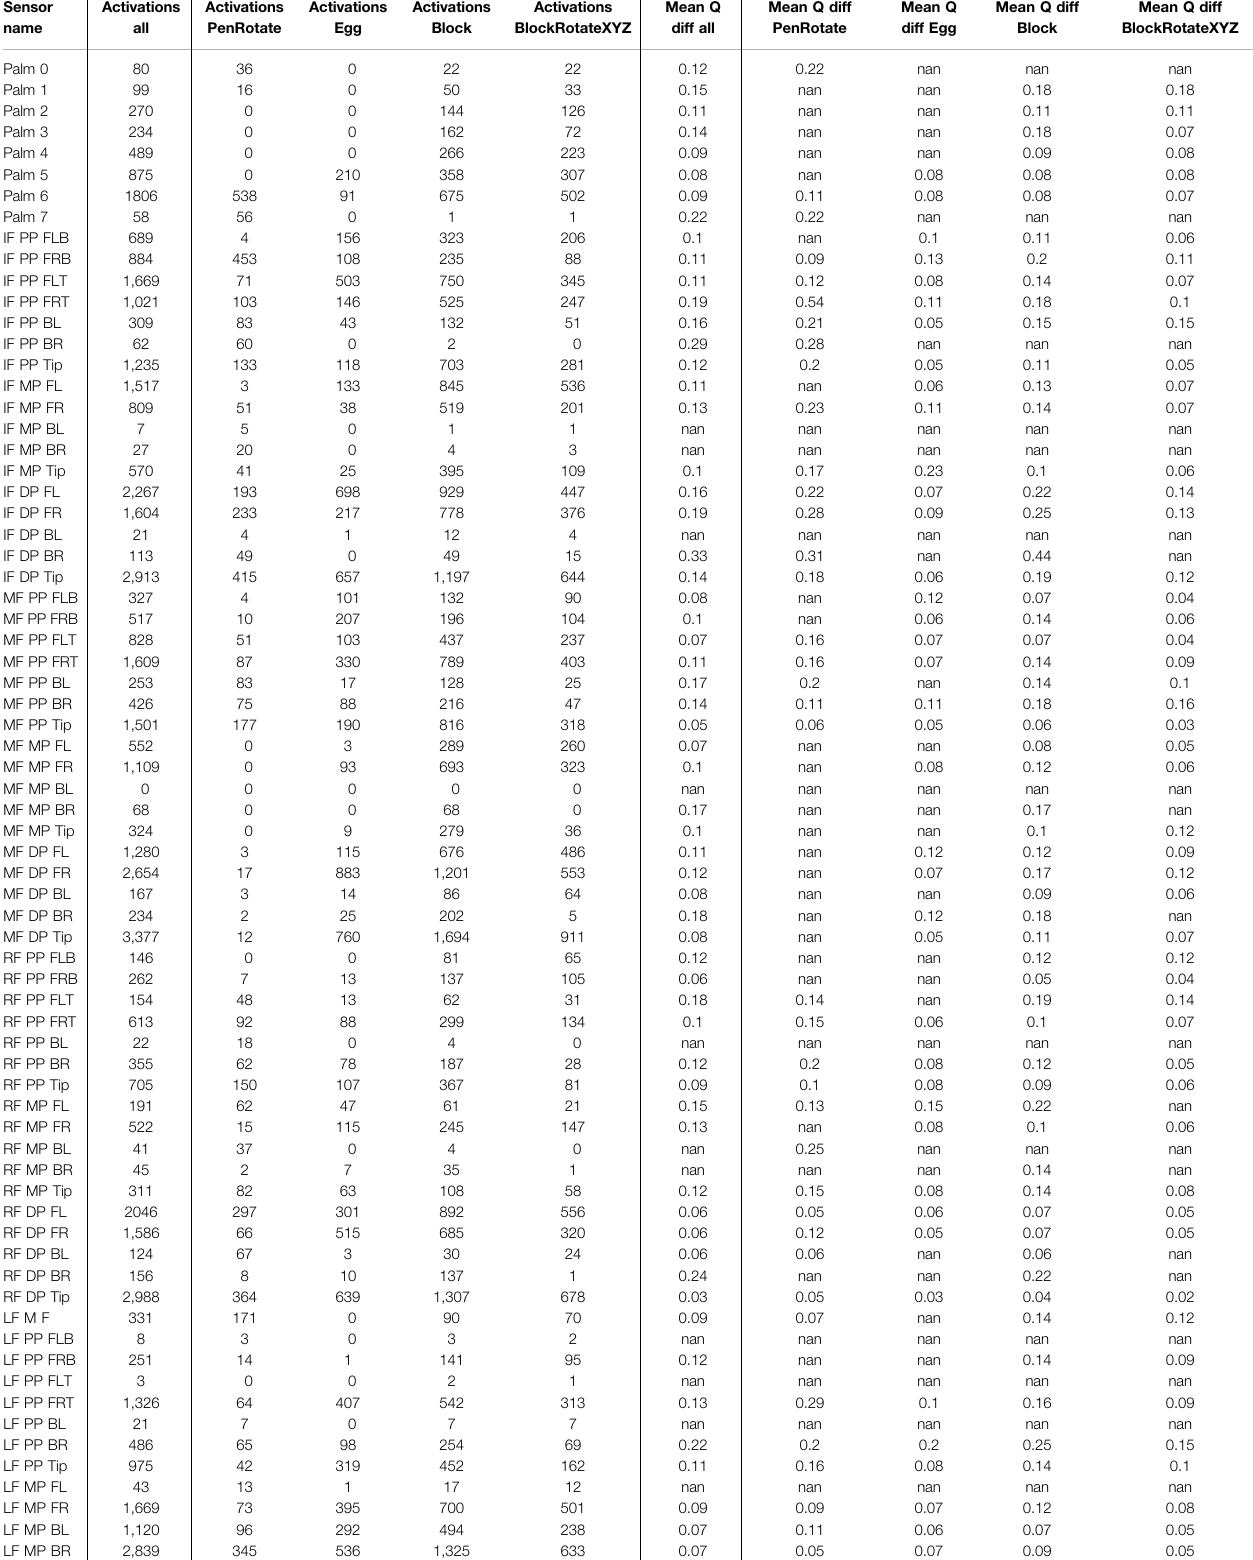
TABLE 8 | Experiment E11. See the visualization of the values in Figure 7